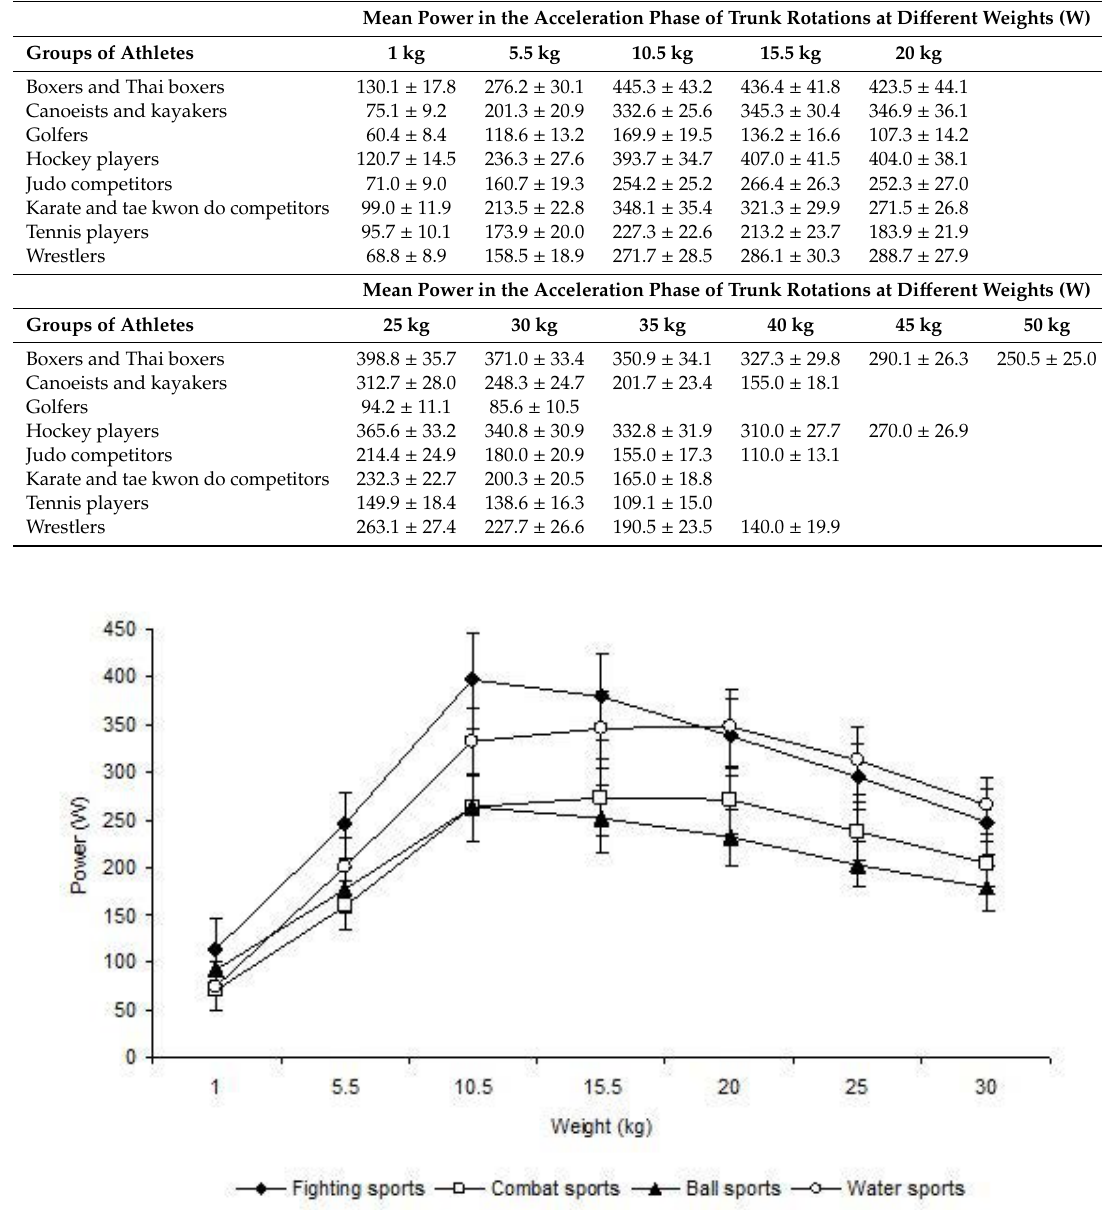
Table 2. Mean power in the acceleration phase of trunk rotations at different weights in groups of athletes of various sports (mean ± SD).